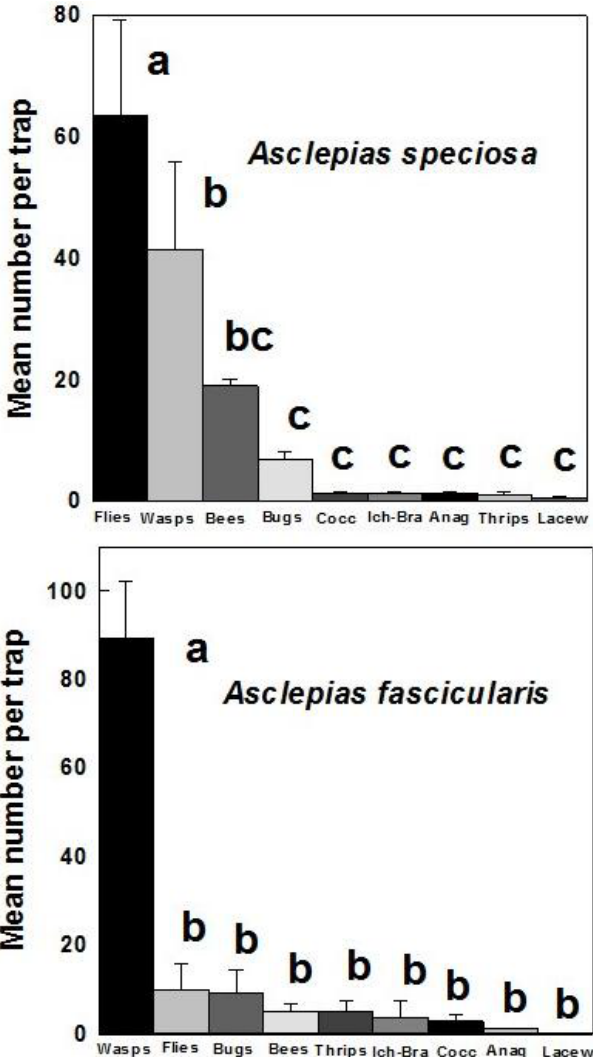
Figure 2. Mean (±SE) number per trap of different categories of beneficial insects trapped on flowering A. speciosa and A. fascicularis during 2013 ( speciosa ) or 2012–2014 ( fascicularis ). Bars denoted by different letters are significantly different ( p < 0.001).